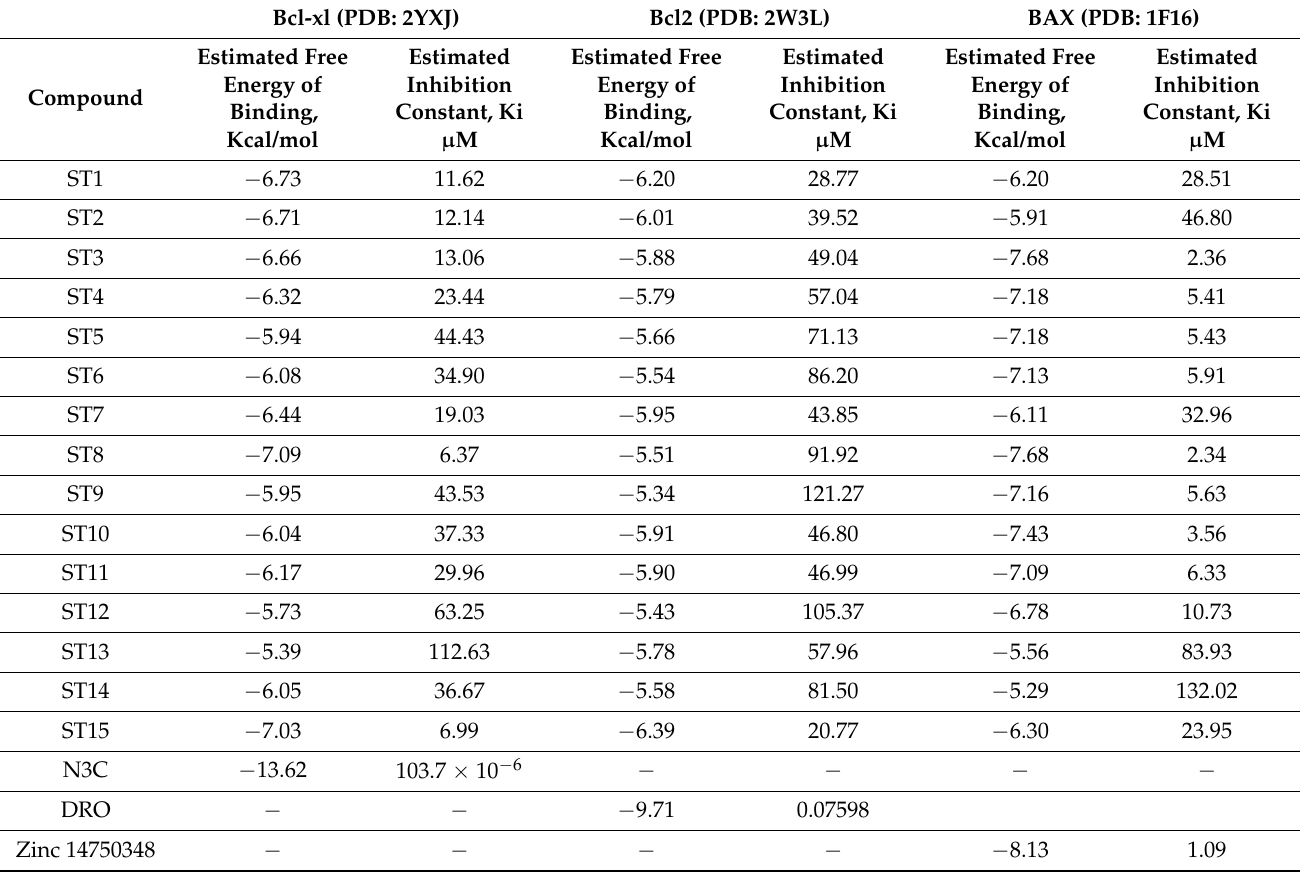
Table 2. Docking simulations for activities of the ST1 – ST15 to Bcl-xl (PDB: 2YXJ), Bcl2 (PDB: 2W3L), and BAX (PDB: